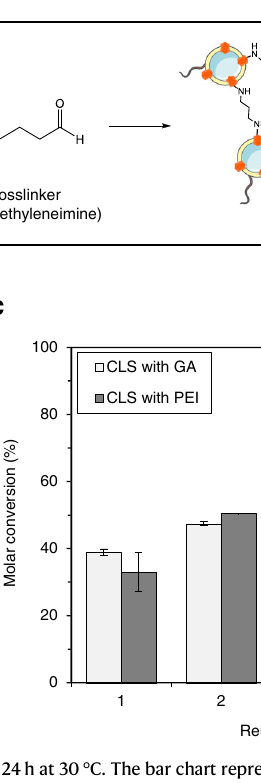
after 24h at 30°C. The bar chart represents the average of technical duplicates. Data are presented as mean values±SD. c Reuses of the CLS for consecutive bio- transformations. Each reuse corresponds to 24h at 30°C. After each reuse, the reaction mix was fi ltered and replaced by a fresh substrate solution. Spheroplasts couldnot be reuseddueto the lack of crosslinking;thus, the biocatalystswerelost in the fl ow-throughafterthe fi rst fi ltration. Thebarchartrepresents the average of technical duplicates. Data are presented as mean